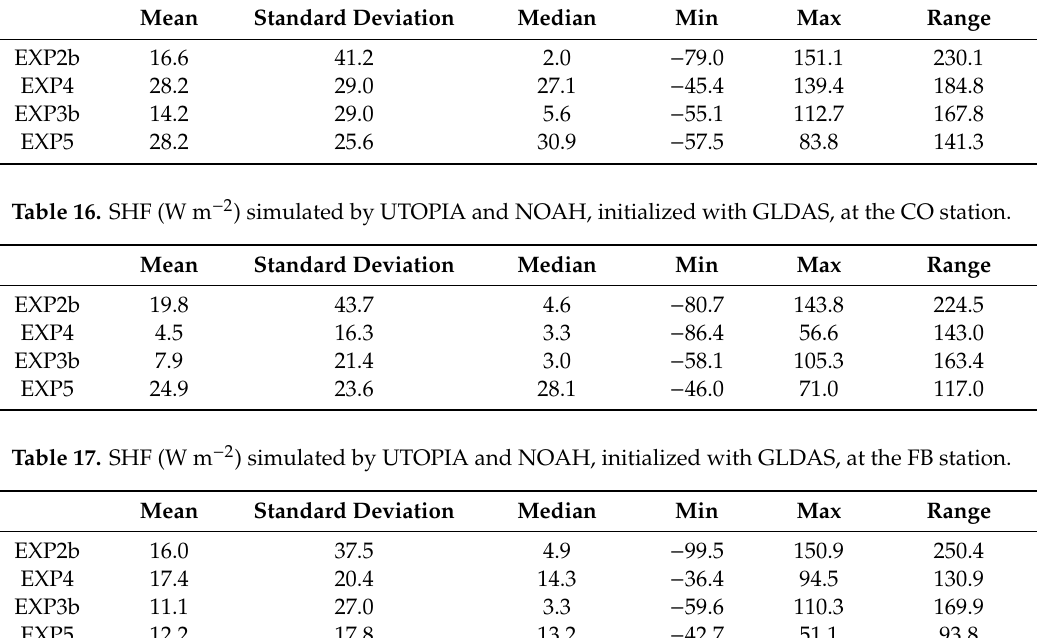
Table 15. SHF (W m − 2 ) simulated by UTOPIA and NOAH, initialized with GLDAS, at the CF station. Mean Standard Deviation Median